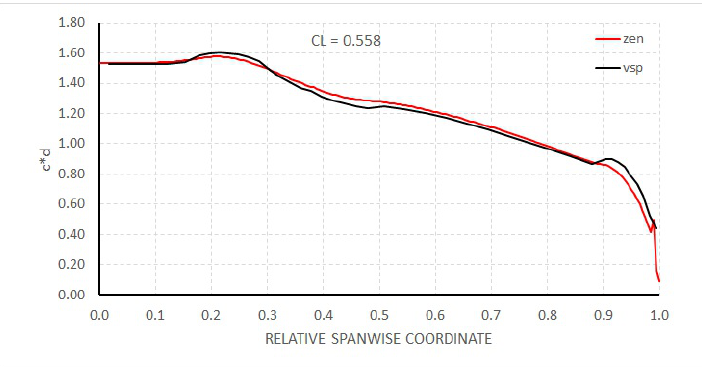
Figure 23. FVM vs. VLM wing spanwise loading comparison (IB-OB-1 power configuration, cruise flight conditions).